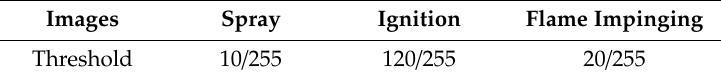
Table 3. Image processing threshold.